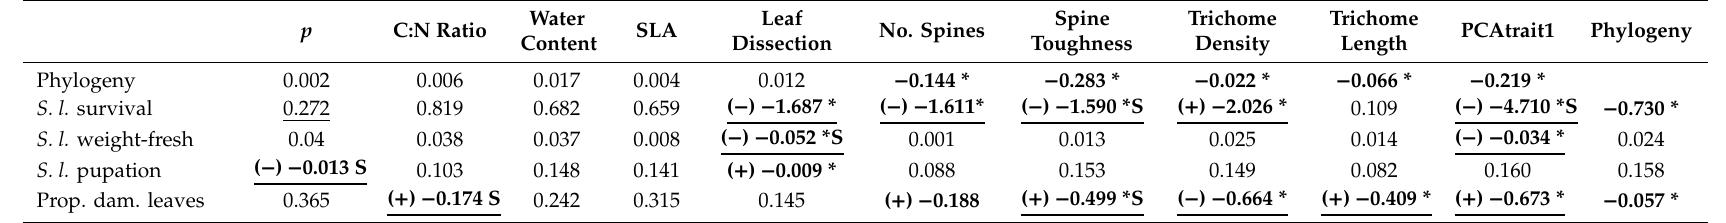
Table 2. The e ff ect of phylogenetic relationships of the species (Phylogeny) and plant traits includes the composite trait (PCAtrait1) on S. littoralis ( S.l. ) survival, fresh weight and pupation and on the proportion of damaged leaves. N = 24 in all cases. The values in the table represent the ∆ AIC value from a comparison of an empty model and a model including the given predictor. Negative ∆ AIC values indicate that the model improved after adding the given predictor, and a more negative ∆ AIC value indicates higher improvement of the model. Negative ∆ AIC values are shown in bold. * indicates that the given predictor had a significant ( p ≤ 0.05) e ff ect when tested separately. S indicates that the predictor was retained in a model selecting predictors using the bi-directional step-wise selection procedure. Underlined values are significant even after accounting for phylogeny. The signs in brackets show the direction of the significant relationships. The line “Phylogeny” shows the e ff ects of phylogeny on the plant traits. The test was performed at the level of single plant